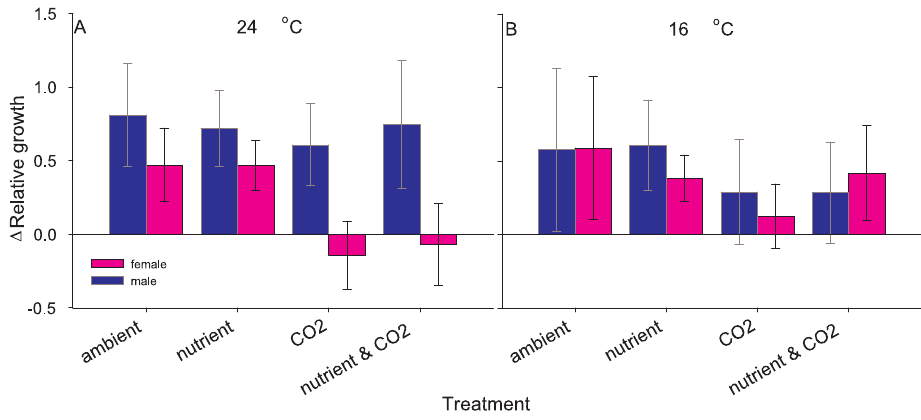
Fig. 3. Relative change in growth rate versus treatment by gender. Corals were grown at 24 ◦ C (A) or 16 ◦ C (B) . Males are represented by blue bars, females by pink. Data for zooxanthellate and azooxanthellate corals have been pooled. Bars represent means ( N = 5 or 6 for males, 3 or 4 for females), error bars are standard